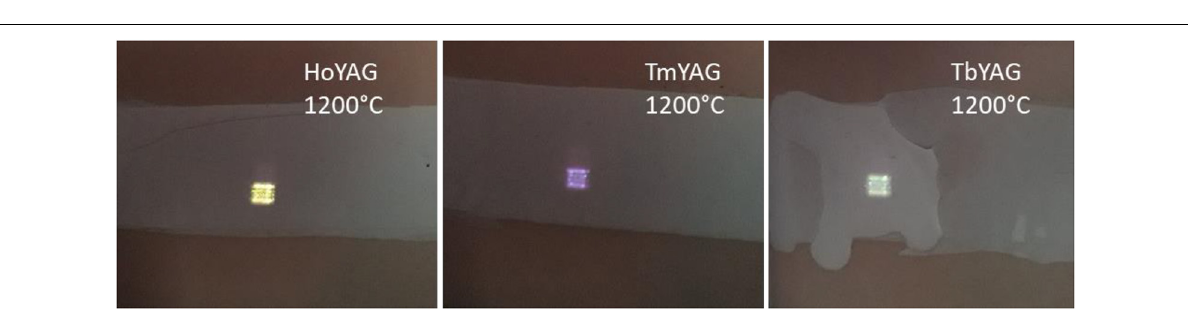
FIGURE 8 | Photograph of the smart glazes exhibiting colored emissions upon NIR excitation (980 nm). The pictures have been taken using a hot mirror filter between the camera and the